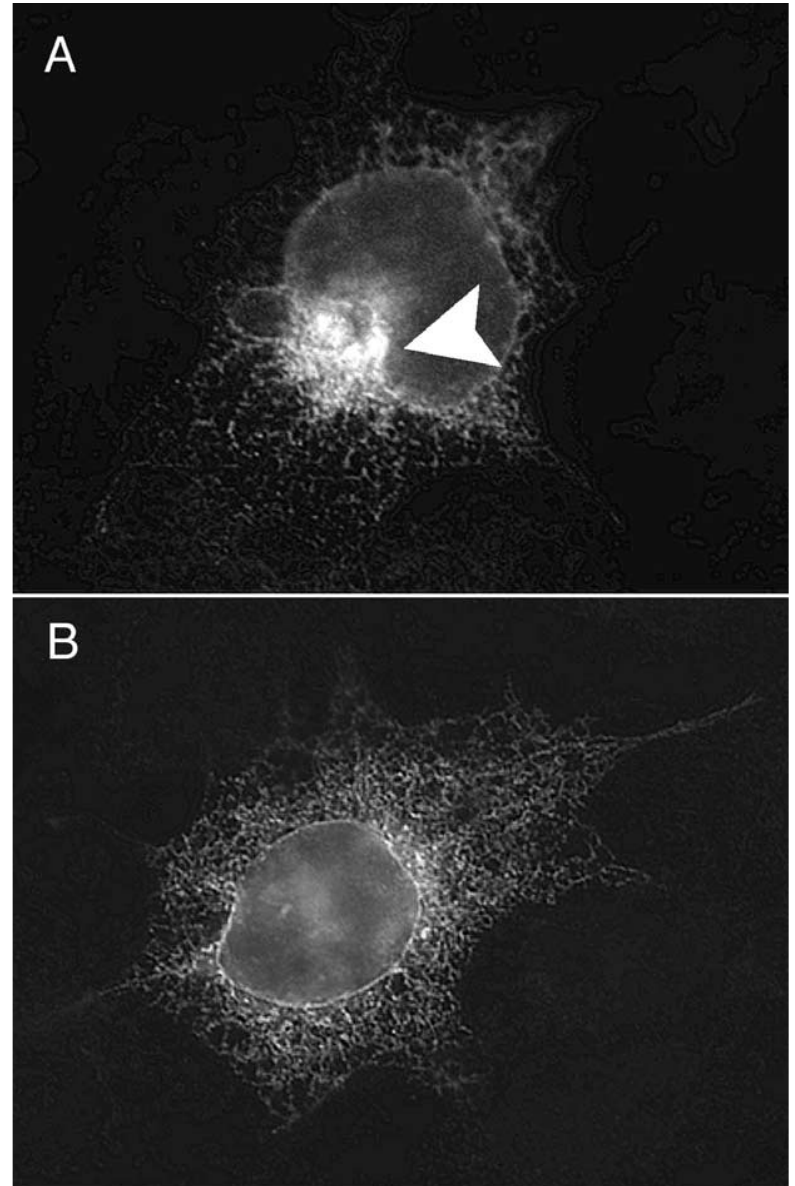
Intracellular location of wild-type (A) or mutant (B) vasopressin hormone precursors. The proteins were expressed in COS cell culture and visualised by immunofluorescence two days after transfection. Wild-type prohormone localises to the ER, seen as a network structure throughout the cell, and the perinuclear Golgi apparatus (arrowhead), indicating the steady state distribution in the secretory pathway. Secretory granules are not seen because COS cells do not have regulated secretion. In cells expressing the mutant a strong ER staining is seen, while the Golgi staining is absent, indicating ER retention